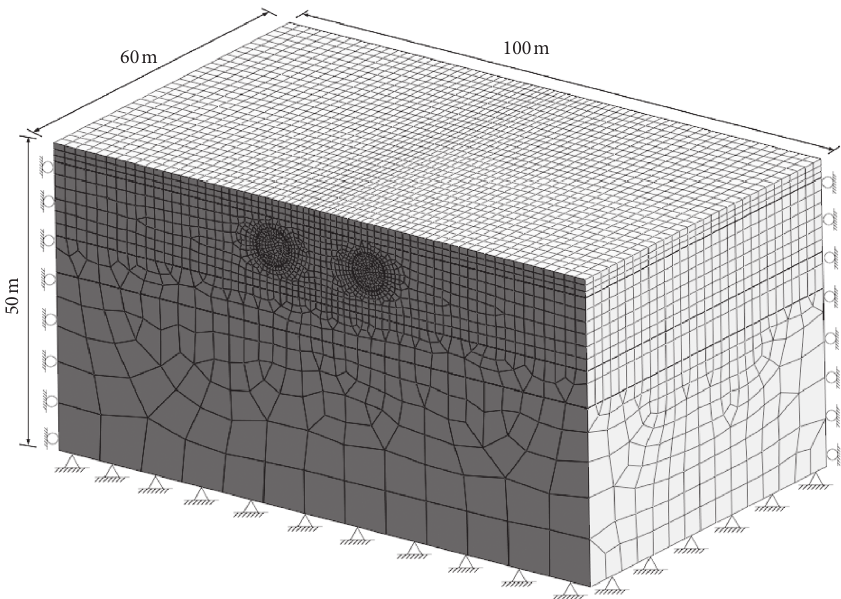
Figure 4: Meshing of the entire finite element